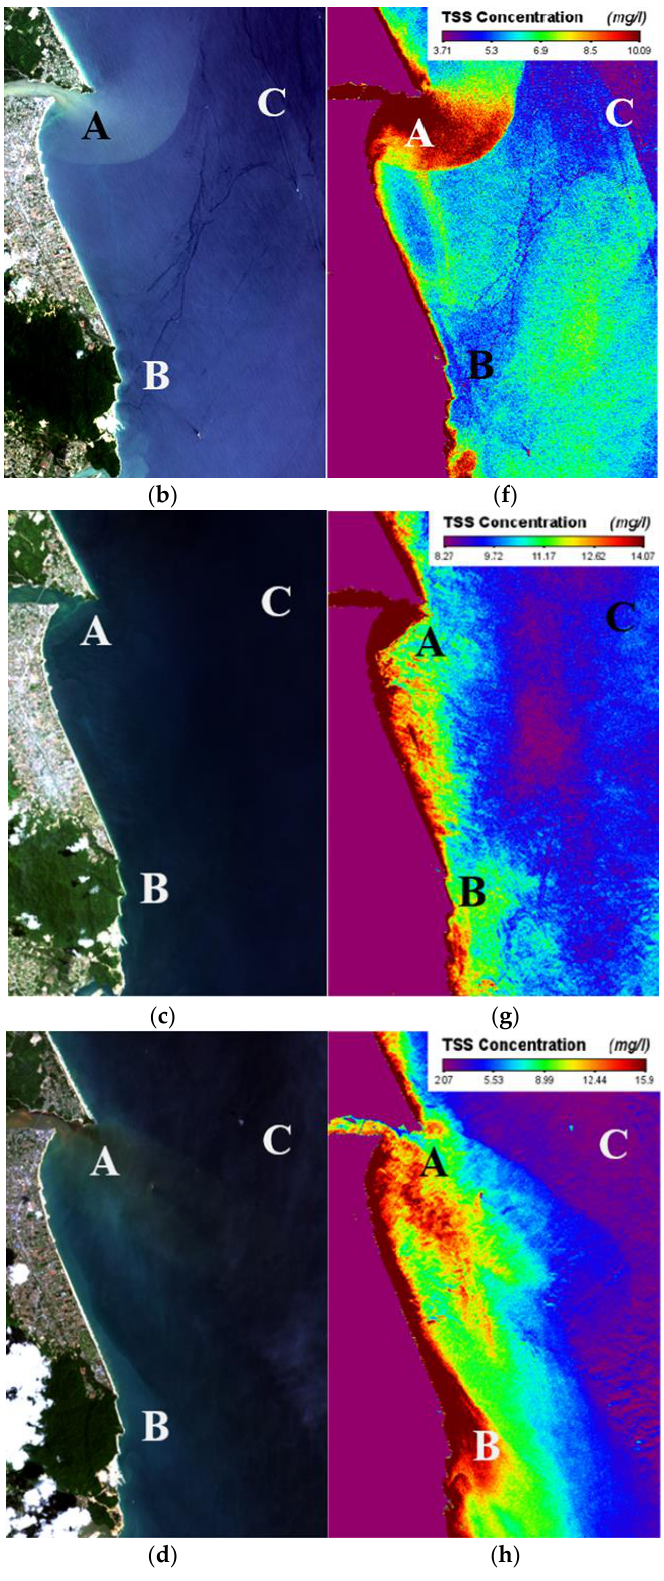
Figure 5. ( a – d ) Colored RGB image acquired from Landsat 8 dataset for the date of 23 November 2018, 17 September 2017, 26 June 2016, and 23 July 2020. ( e – h ) Corresponding TSS map for given date.